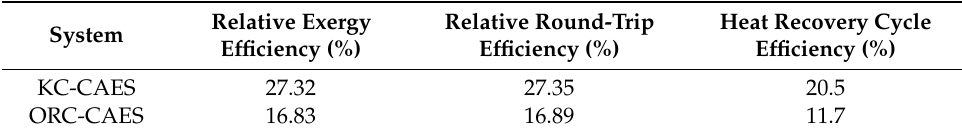
Table 3. Comparison of the efficiency between KC-CAES and ORC-CAES at the optimal point (based on the single